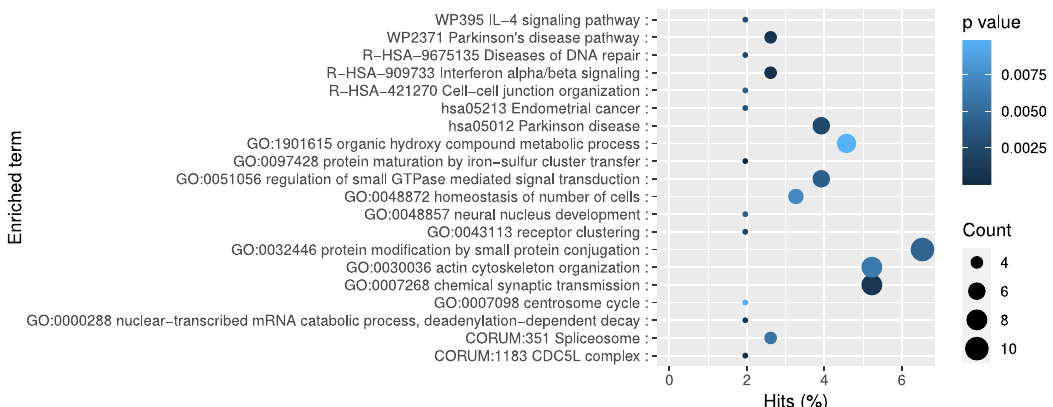
Fig. 4 Functional enrichment analysis of DLB-associated genes. Functional enrichment analysis of the DMC-related genes using Metascape. P values were indicated with colors while the number of associated genes were indicated with circle sizes.